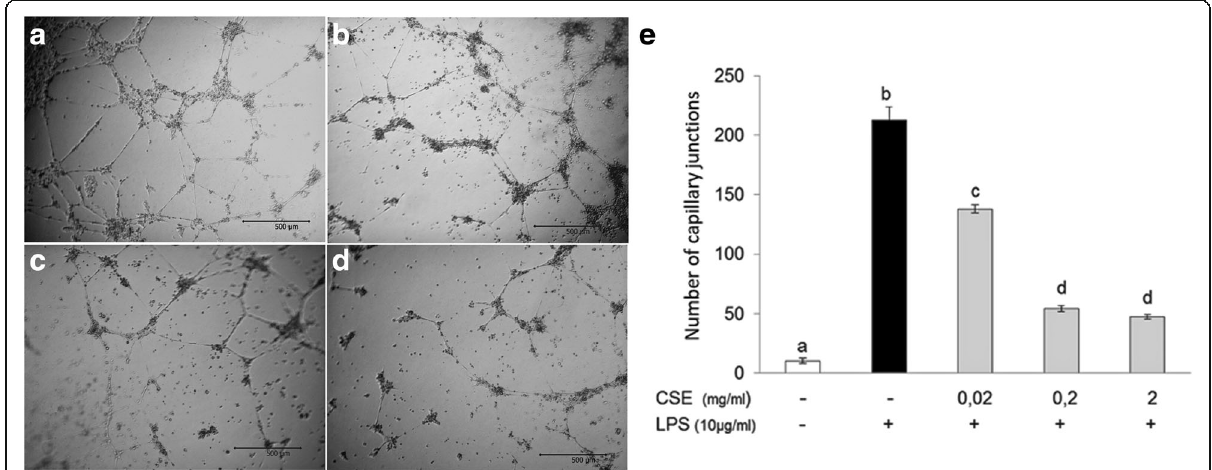
Fig. 4 Effect of Cucumis sativus L. extract on LPS-induced angiogenesis. pAECs were cultured on a extracellular matrix with LPS (10 μ g/ml) in the absence ( a ) or presence of increasing doses (0.02; 0.2; 2 mg/ml) of Cucumis sativus L. extract ( b, c, d respectively) for 18 h. LPS induced a capillary like network ( a , e ) while CSE reduced LPS-induced angiogenesis at any doses tested ( b-e ). Data shown are representative of at least three independent experiments and represent the mean±SEM. Different letters above the bars indicate significant differences (p< 0.05 ANOVA post hoc Tukey ’ s